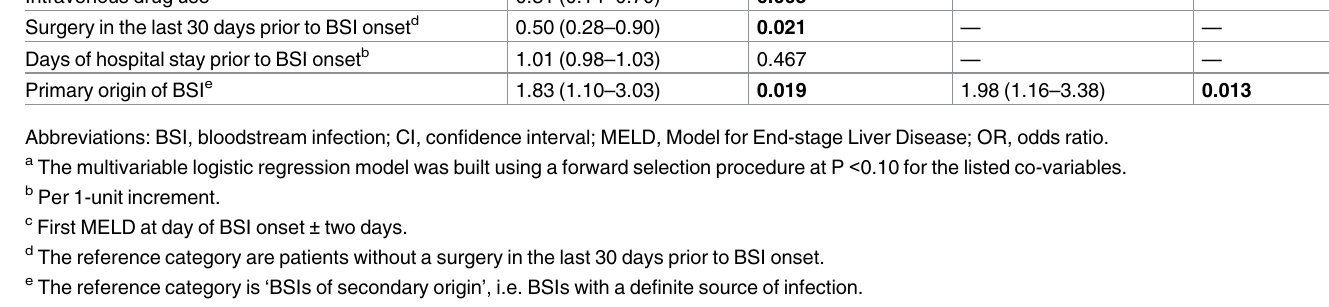
Surgery in the last 30 days prior to BSI onset d